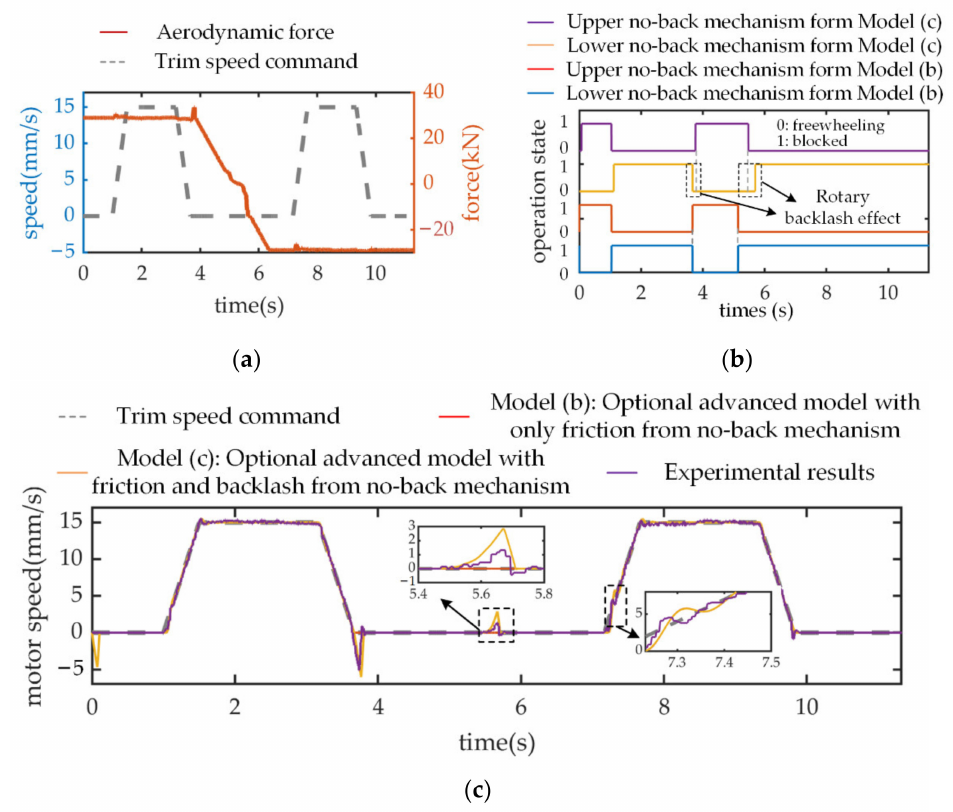
Figure 9. Simulation and experimental results under unipolar speed command and bipolar load. ( a ) No-back friction torque; ( b ) Operation state of pawl and ratchet wheel; ( c ) Motor speed responses from different level models and experimental